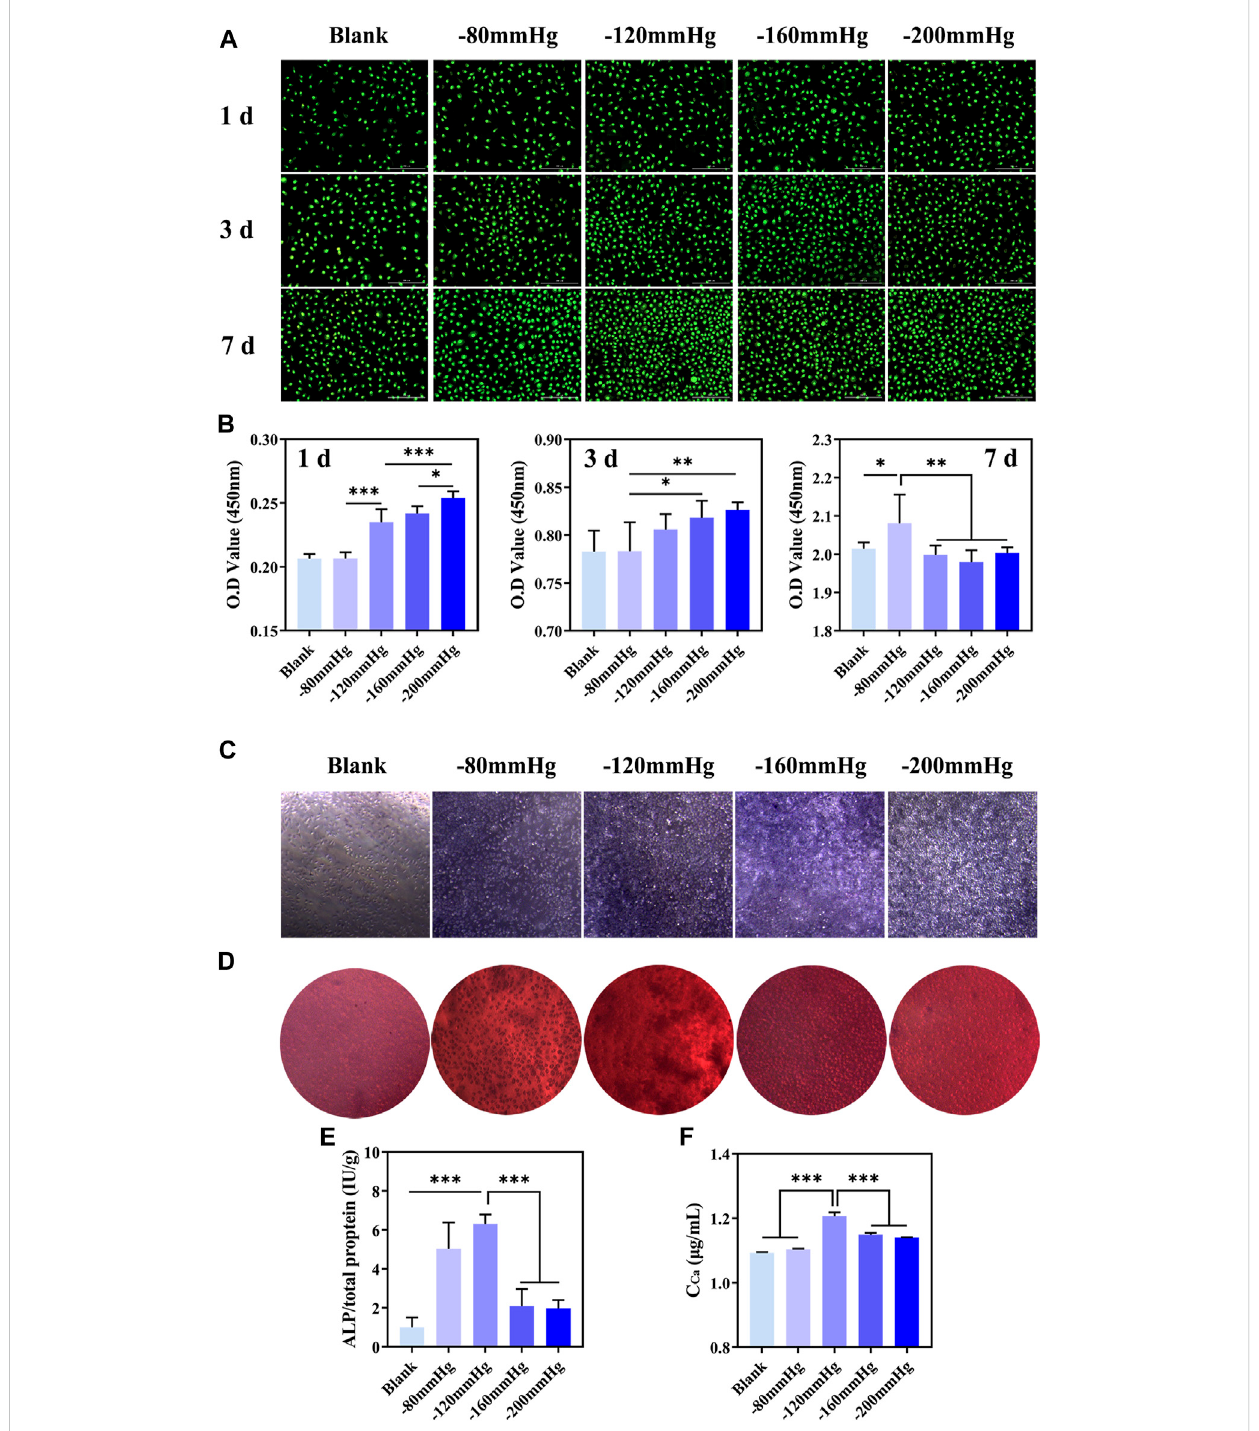
FIGURE 14 In vitro proliferation and osteogenic differentiation of BMSCs after NP treatment. (A) Live/dead staining of BMSCs at 1 d, 3 d and 7 d after NP treatment. (B) CCK-8analysisofBMSCsat1d,3dand7dafterNPtreatment. (C) ALPstainingofBMSCsat7dafterNPtreatment. (D) AlizarinredSstaining of BMSCs at 12 d after NP treatment. (E, F) Quanti fi cation of ALP and calcium content of